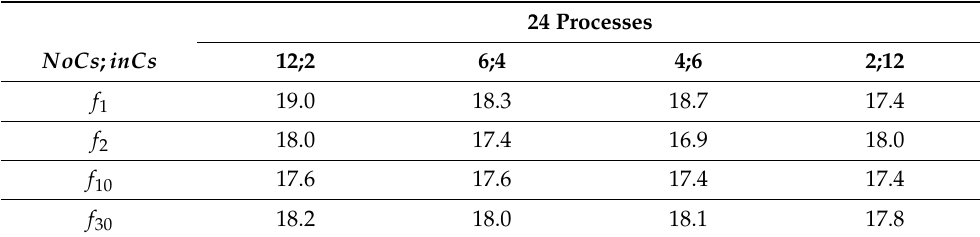
Table 8. Parallel speed-up for the two-level parallel algorithm using groups of processes. Population size = 240. Number of processes =